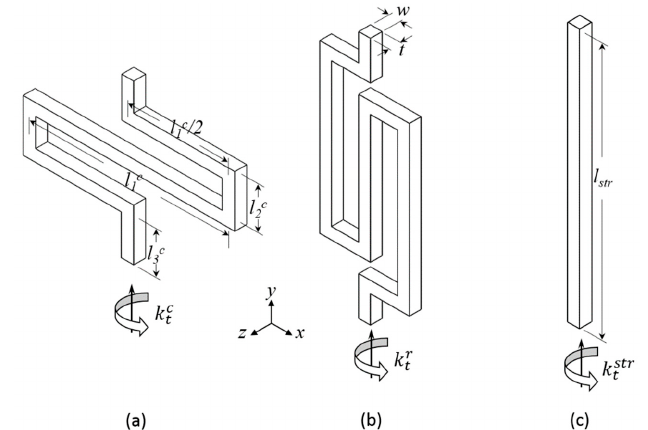
Figure 9. Schematics of ( a ) classical serpentine; ( b ) rotated serpentine; and ( c ) straight beam springs with dimensional parameters.